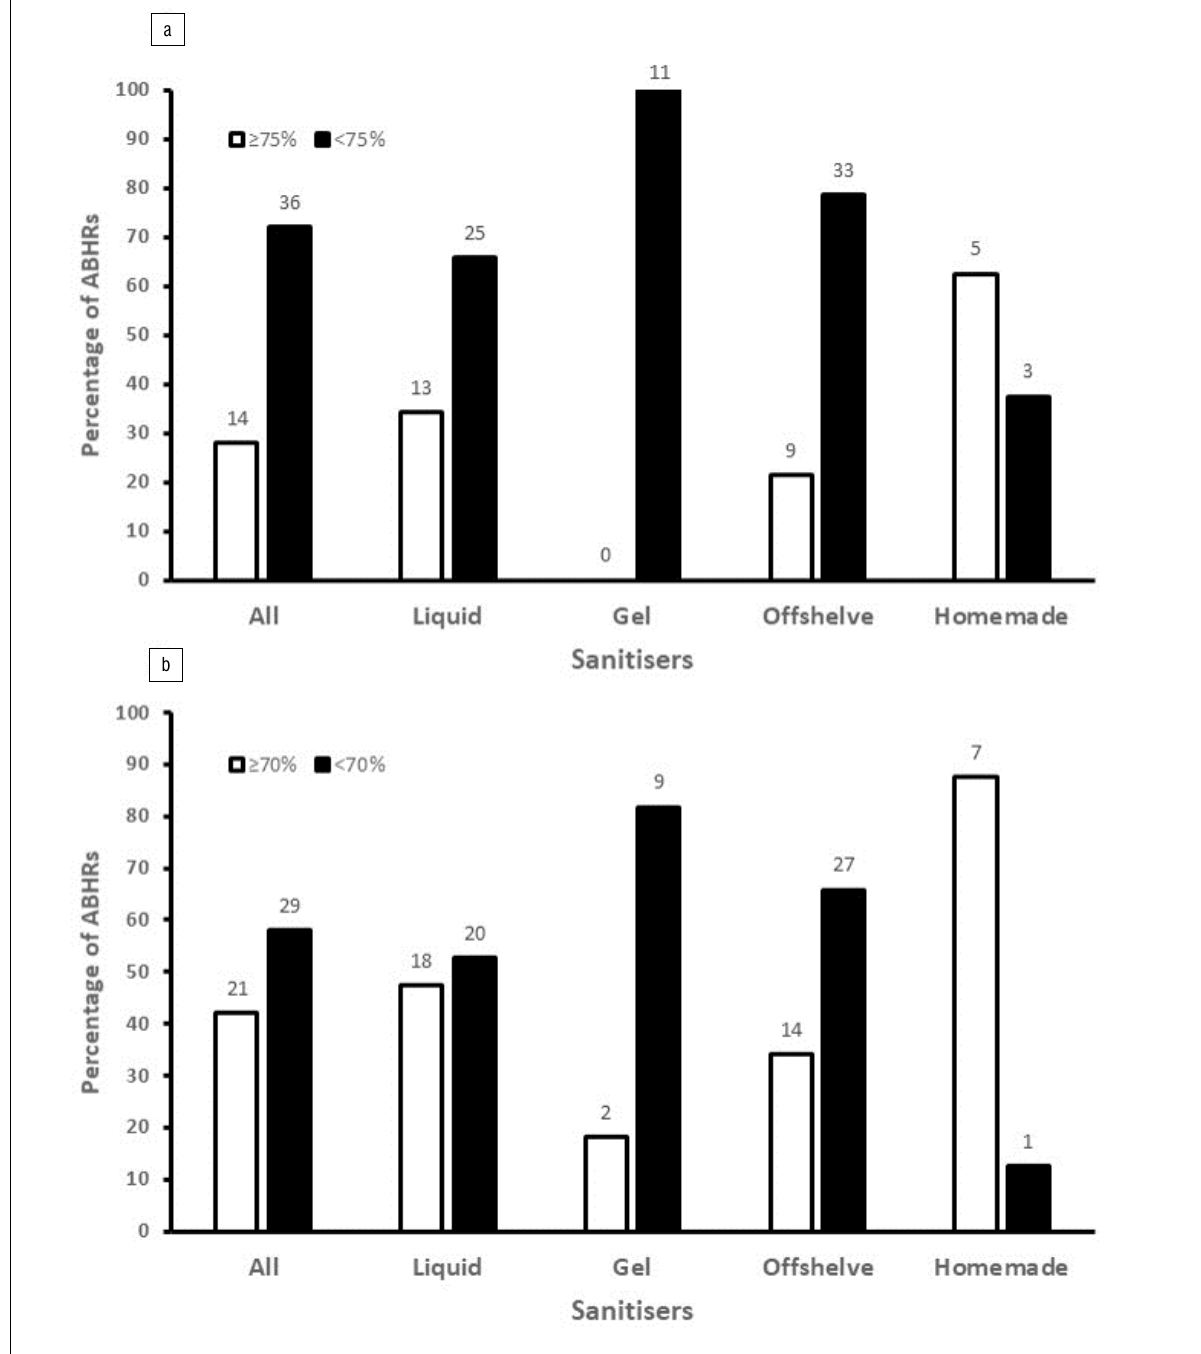
Figure 3: Proportion of products that contain at least (a) 75% and (b) 70% alcohol overall, based on formulation type and